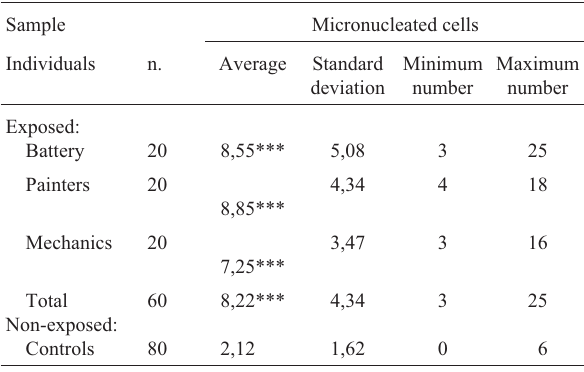
Table II - Average numbers of micronucleated cells (in 3000 cells analyzed per individual) of the three groups of individuals exposed to byproducts of petrol and lead and